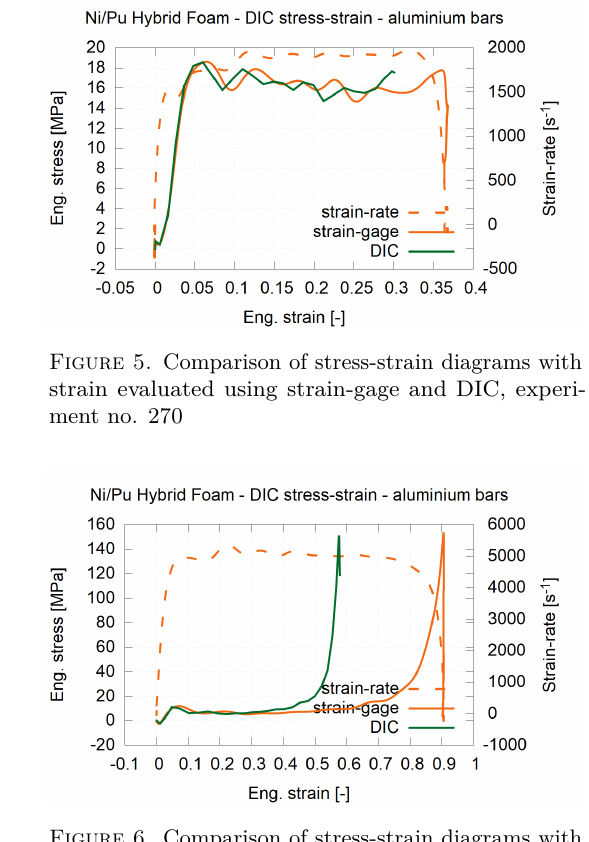
Figure 6. Comparison of stress-strain diagrams with strain evaluated using strain-gage and DIC, experi- ment no. 285